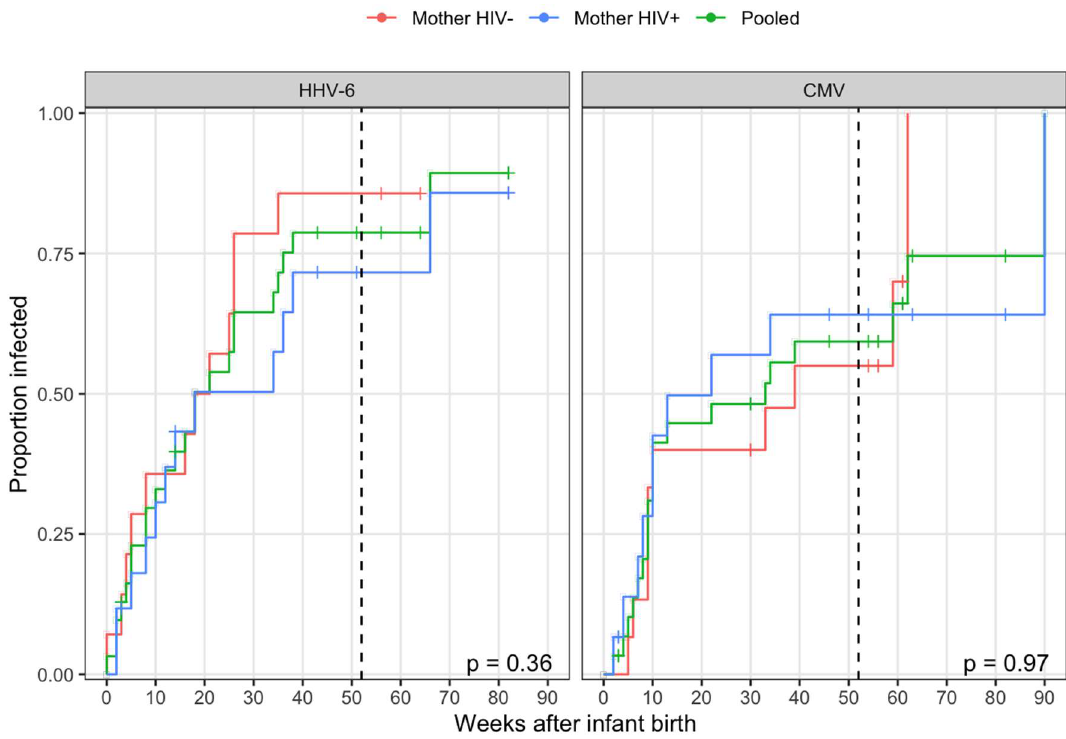
Figure 1. Time taken for the transmission of human herpesvirus 6 (HHV-6) and cytomegalovirus (CMV). Cumulative incidence curves for all transmission events to infants following birth stratified by maternal HIV status with censoring denoted by a plus. The P-values from log-rank tests comparing survival curves (one minus proportion infected) between infants with HIV + and HIV- mothers are displayed in the bottom-right of each panel. The household exposure information was collected through one year (52 weeks; vertical, dashed black line). All events occurring after one year were right-censored for an estimation of transmission risk.